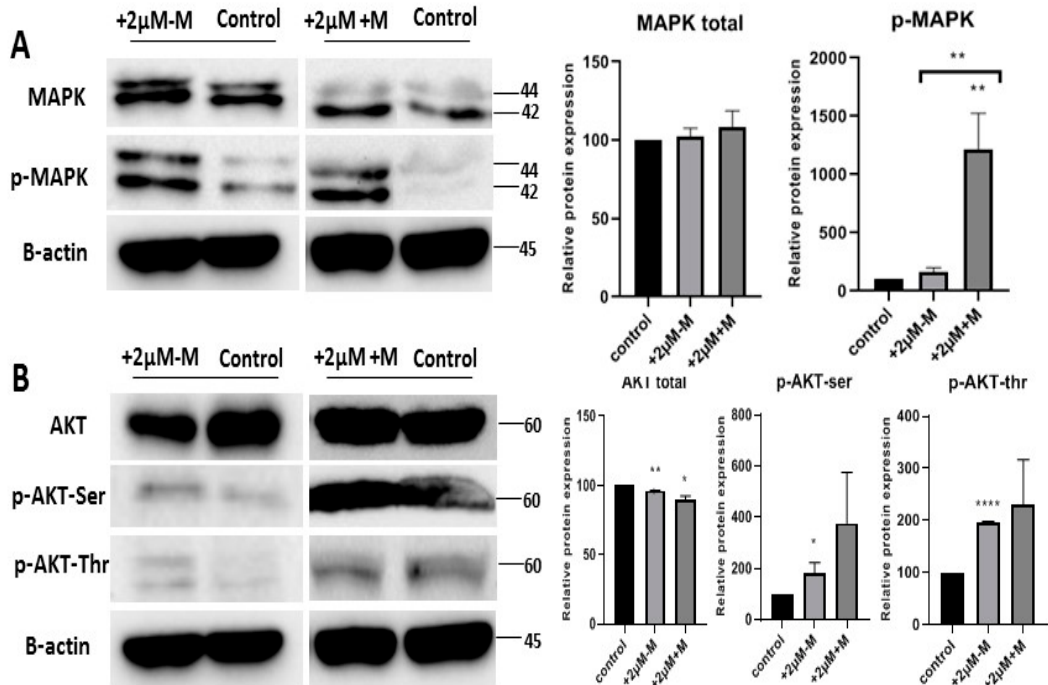
Figure 5. MAP kinase and PI3-kinase signaling pathways activated by rosiglitazone during the enhancing of brown lineage. Total and phosphorylated proteins of derived adipocytes from different experimental groups without ( − ) (control) or with (+) 2 µM rosiglitazone 48 hours (+2 µM+M) or 96 hours (+2 µM-M): ( A ) MAPK (~42/44 kDa) and phospho-MAPK (~42/44 kDa); ( B ) total AKT (~60 kDa), phospho-AKT-serine (~60 kDa), and phospho-AKT-threonine (~60 kDa) normalized to that of β -actin (~45 kDa). Statistical data are presented as mean ± S.E.M. * p < 0.05, ** p < 0.01, *** p < 0.001 versus control.